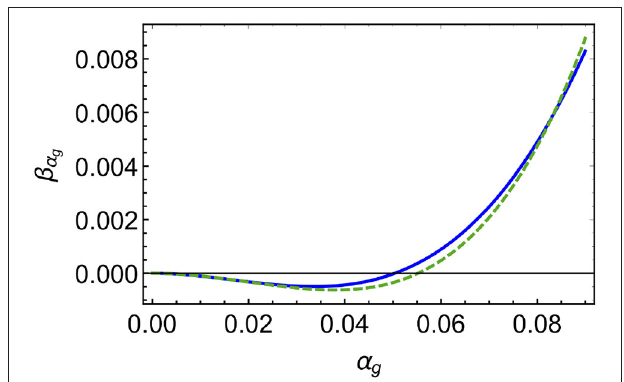
FIGURE 5 | Beta function of the gauge coupling α g for the model in Litim and Sannino (2014) at next-to-leading order (two loop, blue continuous line) and next-to-next-to-leading order (three loop, green dashed line), cf. Equation (34) for the two-loop beta function. The fixed-point value for α y at the corresponding order has been inserted and ǫ 0.1 has been =